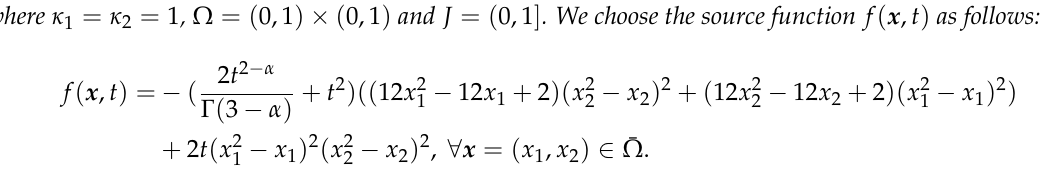
(cid:107) u ( t n ) − u n n